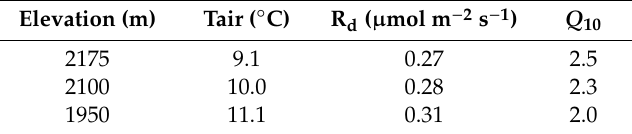
Table 4. Average air temperature during summer (T air ), corresponding night-time dark respiration (R d ), and the temperature sensitivity of respiration ( Q 10 ) of current-year Pinus cembra needles at the krummholz limit (2180 m a.s.l.), the treeline (2100 m a.s.l.), and the forest limit (1950 m a.s.l.) assessed at the prevailing temperature conditions in summer 2007 on Mount Patscherkofel. After